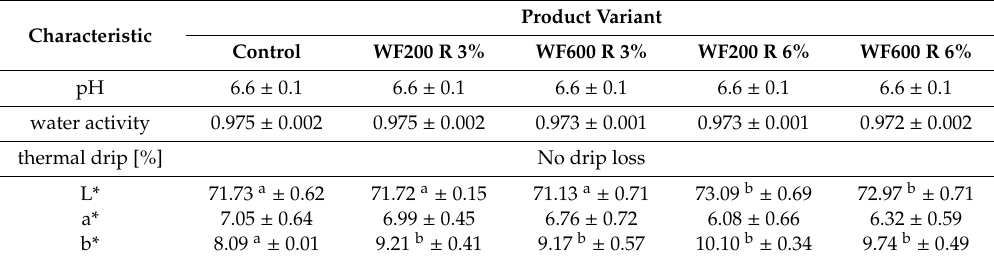
Table 2. Selected quality characteristics of the model homogenized sterilized canned meat products (mean ± standard